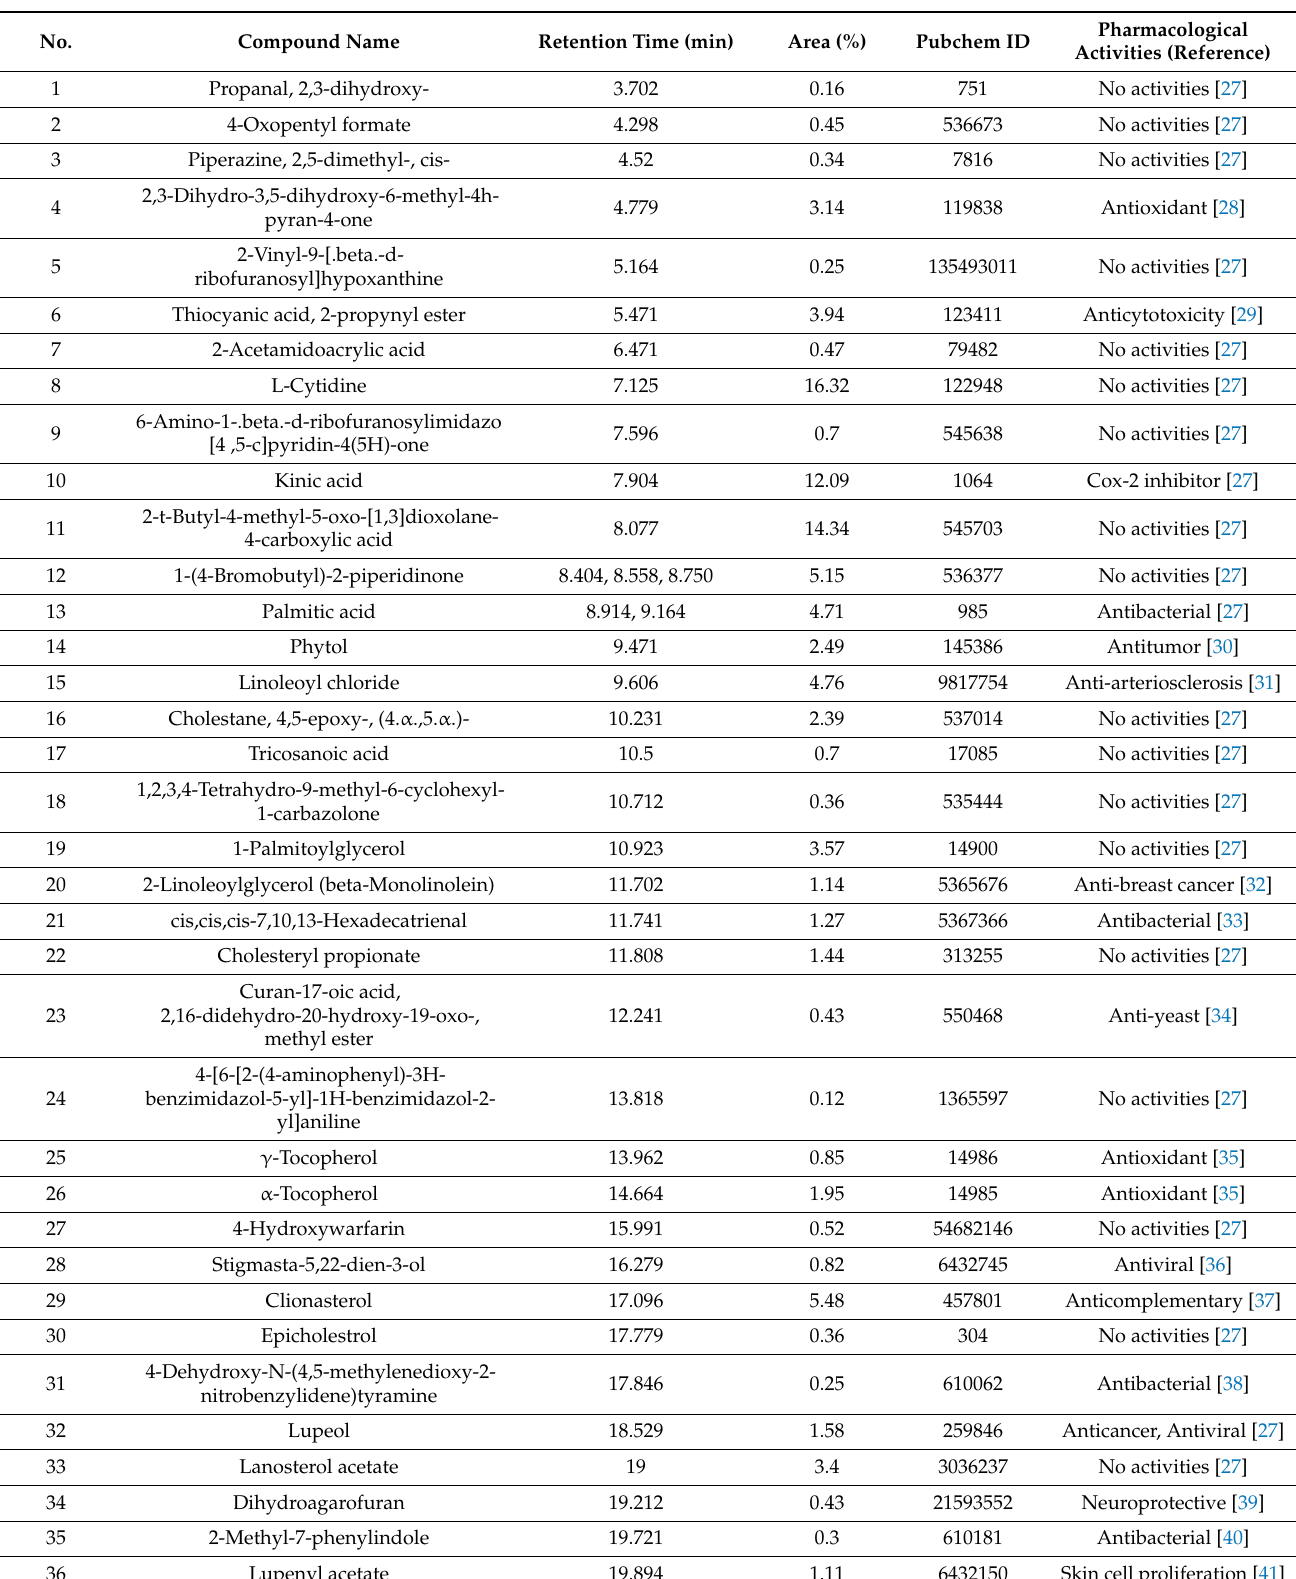
Table 1. A list of the identified 36 chemical compounds from M. alba L. leaves through